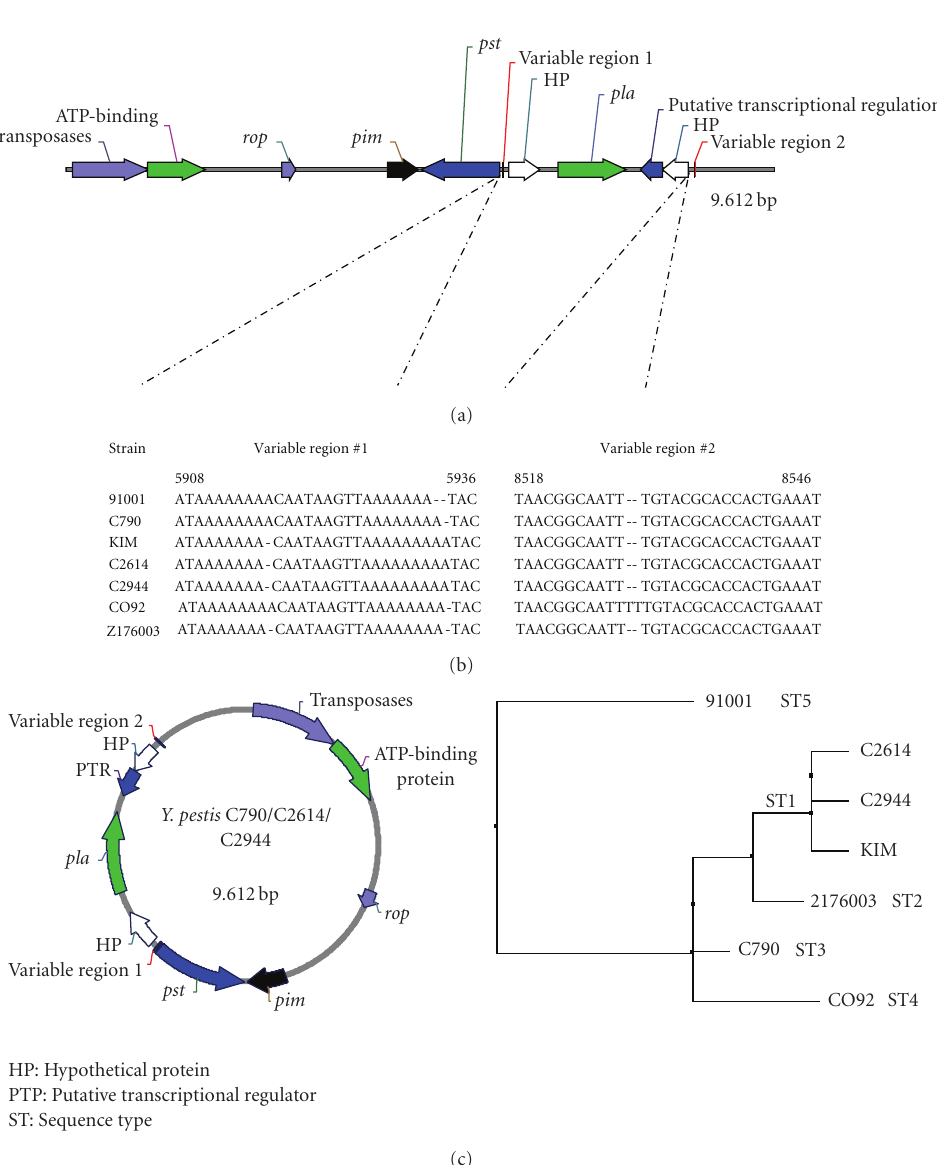
Figure 3: Structural comparison of the pPCP1 plasmids in the FSU’s Y. pestis strains and a previously characterized strain Y. pestis